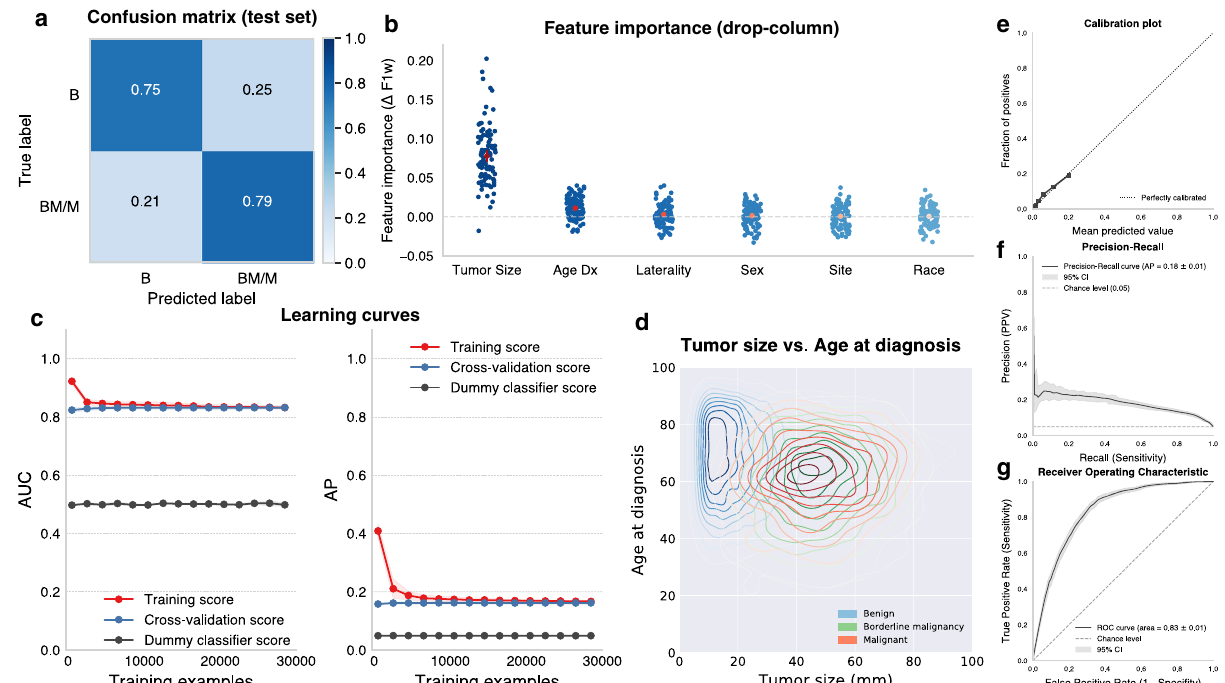
Fig. 3 Performance of the malignancy classi fi er. a Confusion matrix illustrating predicted vs. true labels for the malignancy classi fi er, as evaluated on the test set. Values are normalized across each row. B Benign, BM/M Borderline malignancy/Malignant. b Drop-column feature importance showing decrease in classi fi er performance resulting from dropping a given feature, in decreasing order of importance. The red dot indicates the mean and error bars 95% con fi dence intervals. c Learning curves illustrating training (red line) and cross-validation (blue line) model performance (measured by Area under the receiver operating characteristic curve and Average Precision) as a function of the number of patients used in training the classi fi er. The point of convergence between the training and cross-validation curves indicates when adding more cases to the training no longer results in an improvement in performance. Shaded outlines represent 1 standard deviation. The gray line represents the performance of a dummy classi fi er, which randomly generates predictions on the basis of the class distribution in the training set. d Bivariate kernel density plot (can be understood as a “ 2-dimensional histogram ” ) of tumor size vs. age at diagnosis. e Calibration plot, as evaluated on the test set. f Precision-recall curve and receiver operating characteristic curve ( g ) for Benign vs. Borderline Malignant/Malignant meningioma classi fi cation. For f , g the gray dashed line indicates chance-level performance and the shaded outline represents the 95% con fi dence